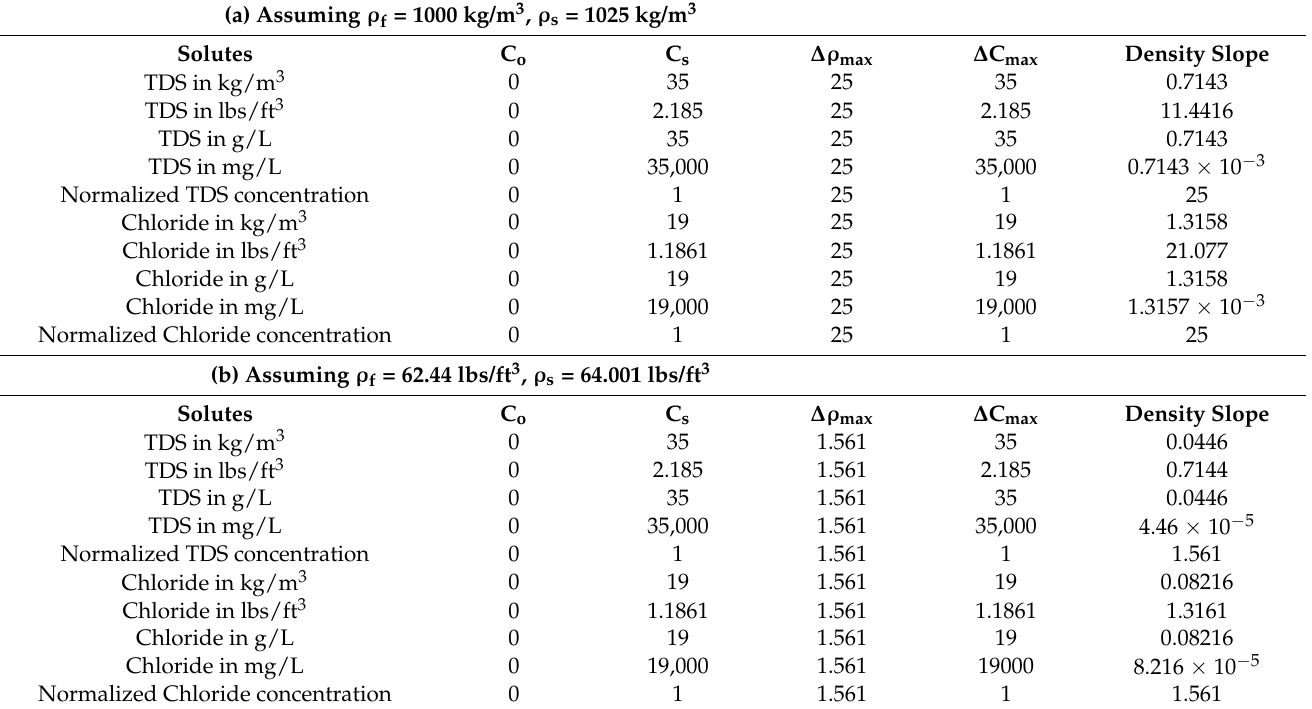
Table 4. Commonly used density slope